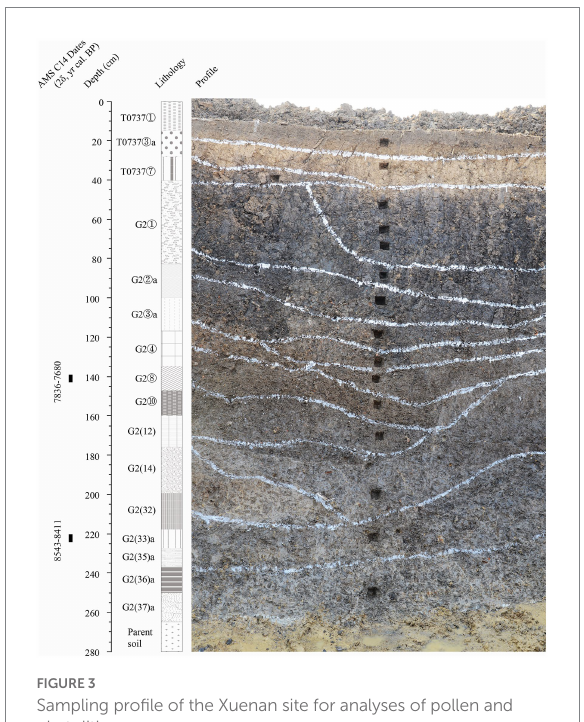
FIGURE 3 Sampling profile of the Xuenan site for analyses of pollen and